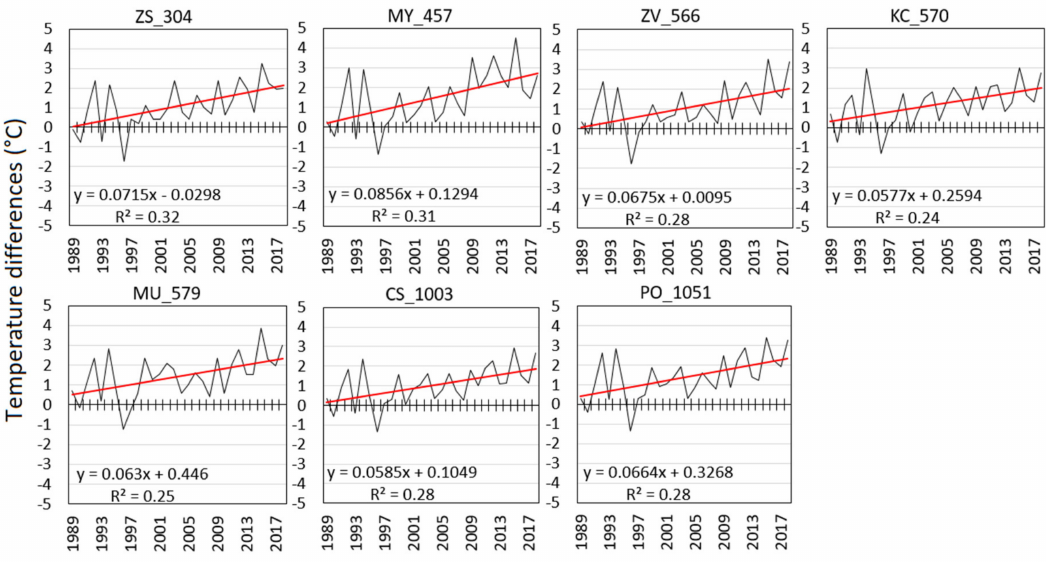
Figure 4. Di ff erences of temperature during summer seasons in 1989–2018 (T VII–IX ) compared to the normal of 1961–1990 (TN VII–IX ): the black line shows the temperature di ff erence in ◦ C. The red line trends indicate the linear relations including their numerical representation.